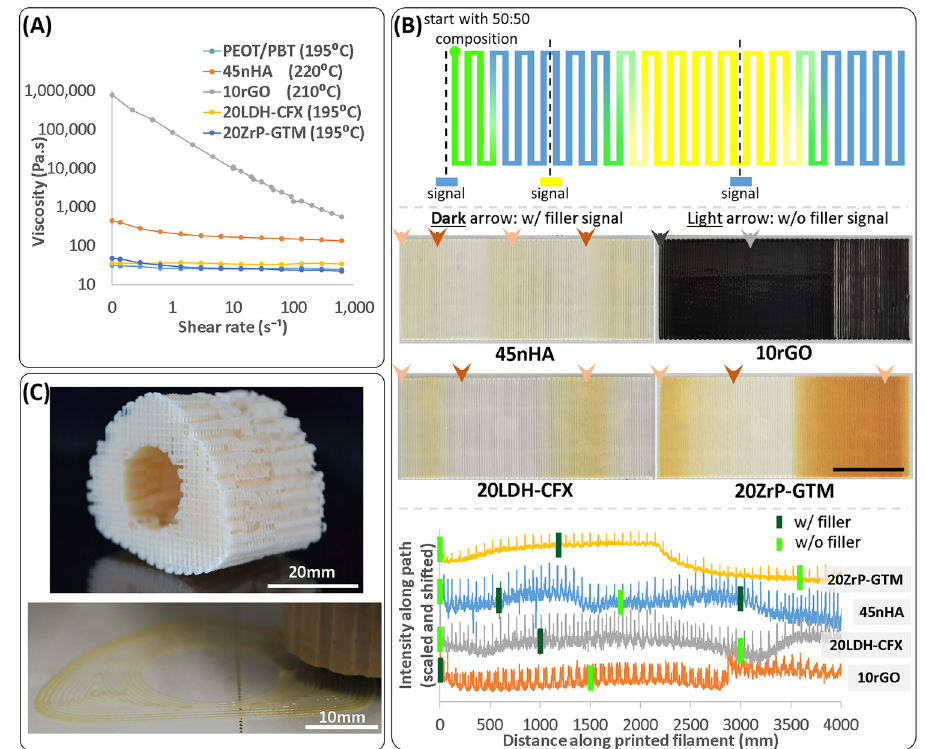
Fig. 3 The printhead was validated with a material library developed for bone TE. Extrusion and continuous gradient production were possible with fi ve different materials covering a wide range of viscosities. Rheological measurements consisted of viscosity measurements at various shear rates at empirically determined printing temperatures for the materials ( A ). Gradient printing with the selected materials was tested by printing continuously in a single plane, while switching pressures from being applied only to one material to only the other material, and monitoring how the extruded composition changed in response ( B ). The top panel in B schematically shows the printing path using two different materials (shown in blue and yellow), the position along the print path where pressure was applied to one material, but not the other (denoted by the signal in the respective color), and how that changed the composition along the print path. The middle panel shows the printed gradients using the four fi ller-loaded materials switching with PEOT/PBT without fi ller. The bottom panel shows the intensity of the middle panel images along the print path plotted against the print length. The empirical knowledge of composition switching time after a signal application was used to plan the printing of a long bone defect-shaped scaffold with a polymer-only core and a HA-loaded polymer cortical region ( C ). The top image in C shows a long bone defect-shaped scaffold printed with PEOT/PBT alone, and the bottom image shows a similar scaffold being produced with a HA composition